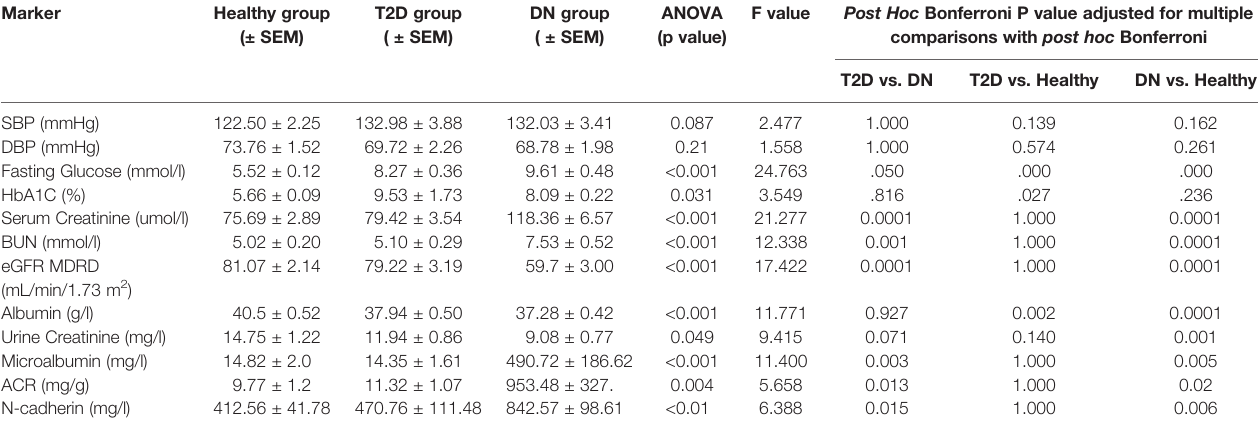
TABLE 2 | Clinical and Biochemistry characteristics of study